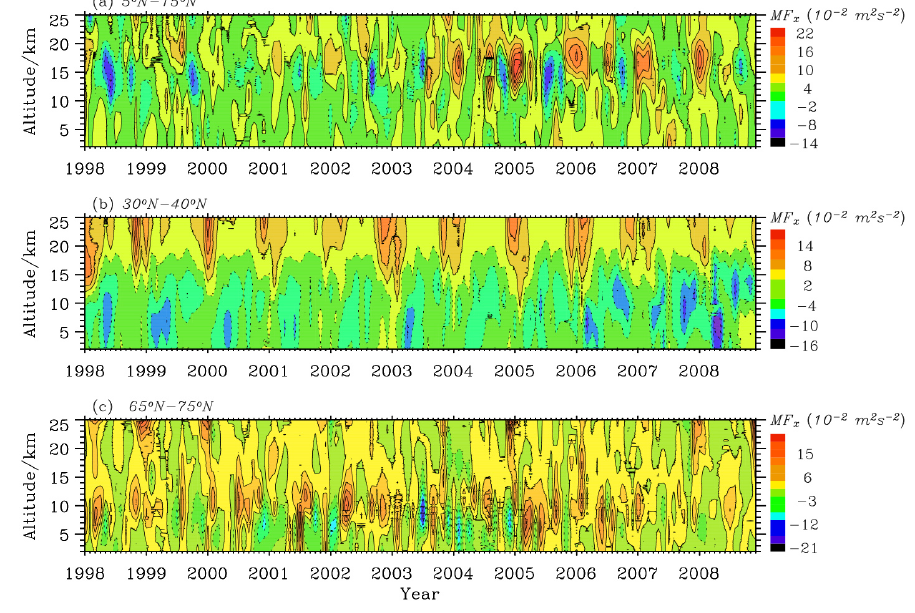
Figure 10. Monthly averaged zonal momentum fluxes (in 10 − 2 m 2 s − 2 ) at low (a) , middle (b) and high (c) latitudes.